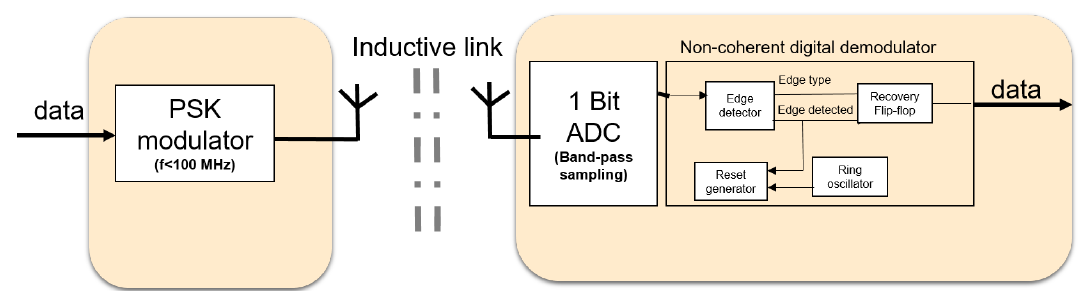
Figure 2. System architecture of the communication system for